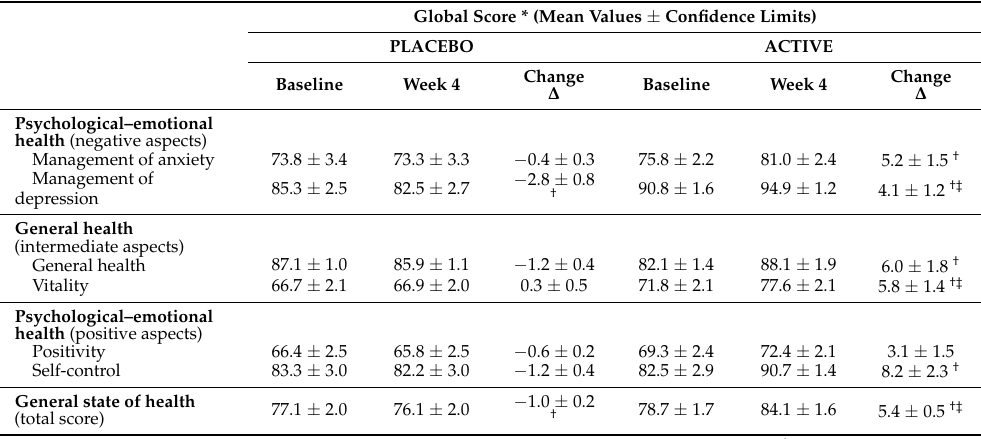
Table 3. Health-related quality of life assessed through global scores for the Psychological General Well-Being Index (PGWBI) questionnaire in both groups (PLACEBO and ACTIVE) at baseline and at the end of the double-blind supplementation period.